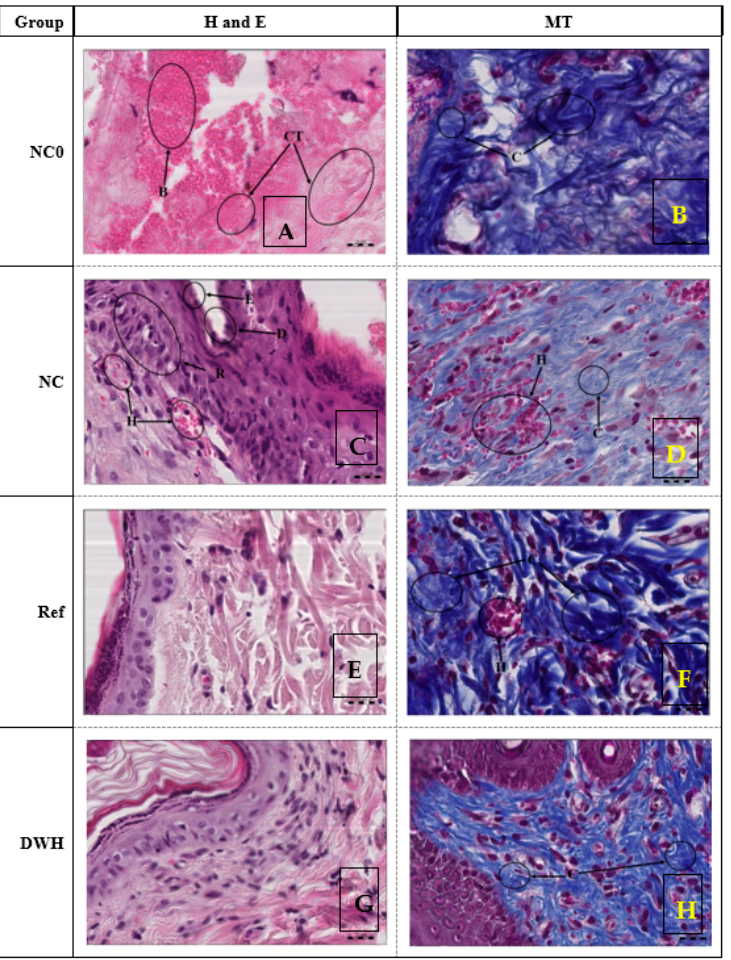
Figure 13. Histopathological sections of skin samples stained with H and E (a, c, e, and g) and MT (b, d, f, and h) after topical application of blank gel on the wounds of normal rats (NC) and diabetic rats (DC), and Fucidin cream (REF), and DWH gel (TEST) on the wounds of diabetic rats. Magnification: × 400.